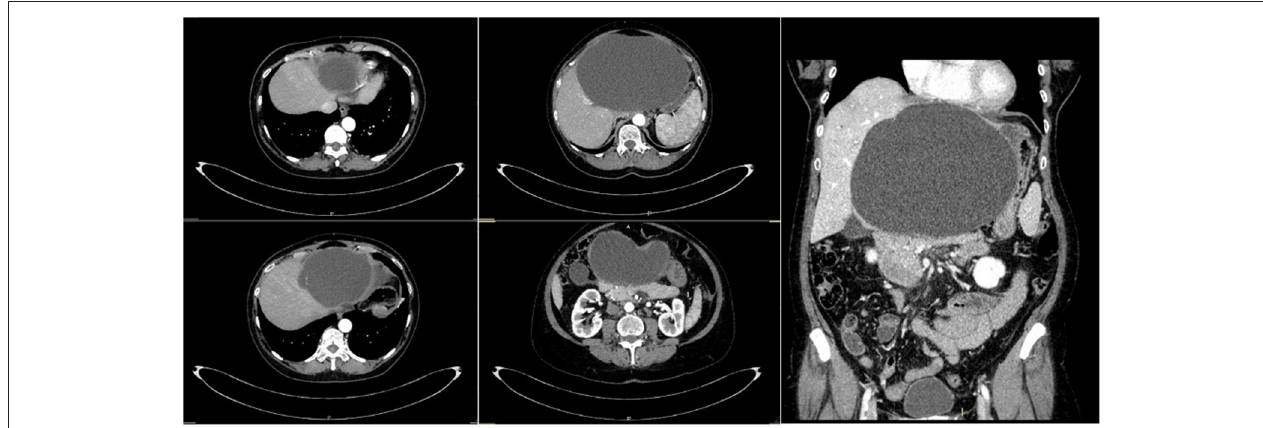
FIGURE 1 | CT scan of Patient 1 showing the liver cyst that occupies all the left